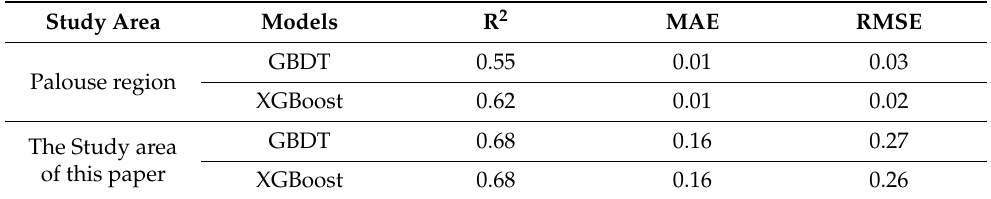
Table 7. Prediction accuracy of the two models in different regions.